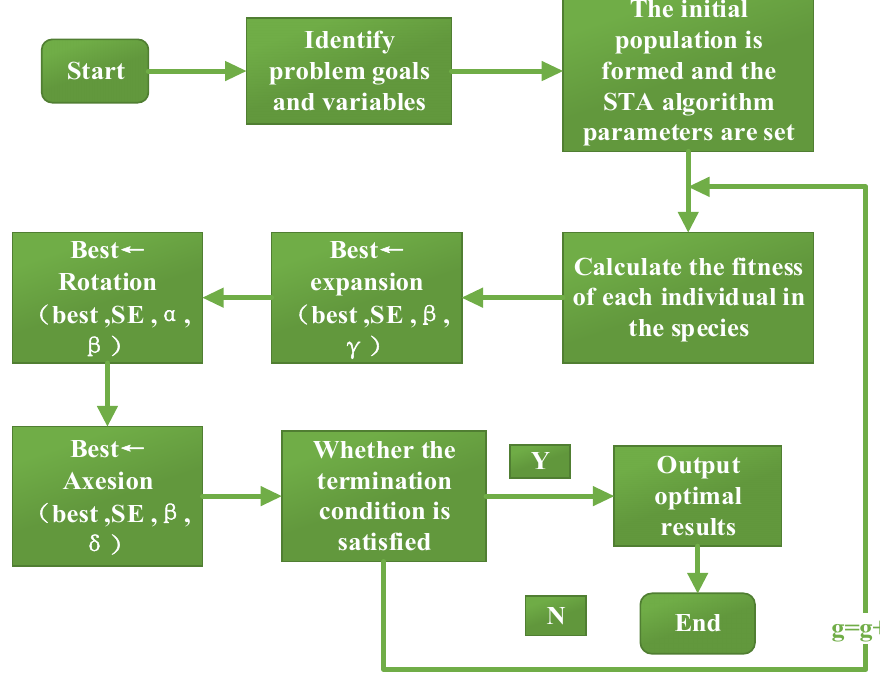
Figure 1. State transition algorithm (STA) flowchart.